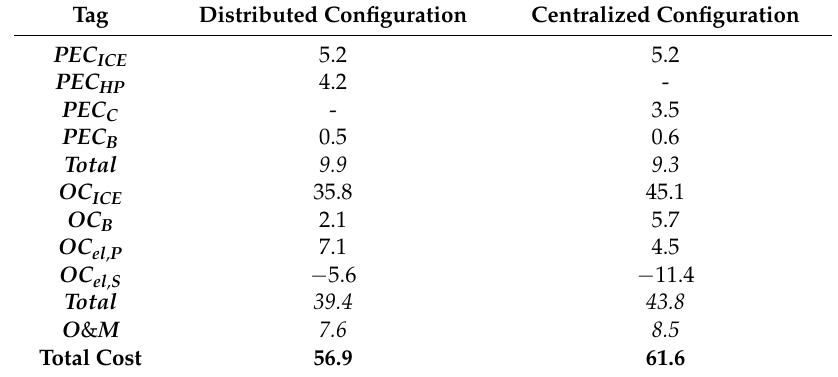
Figure 5. Installation, energy, and maintenance annual costs using the optimal control strategy. Table 4. Annual costs of the optimal distributed and centralized configurations, k € /yr.